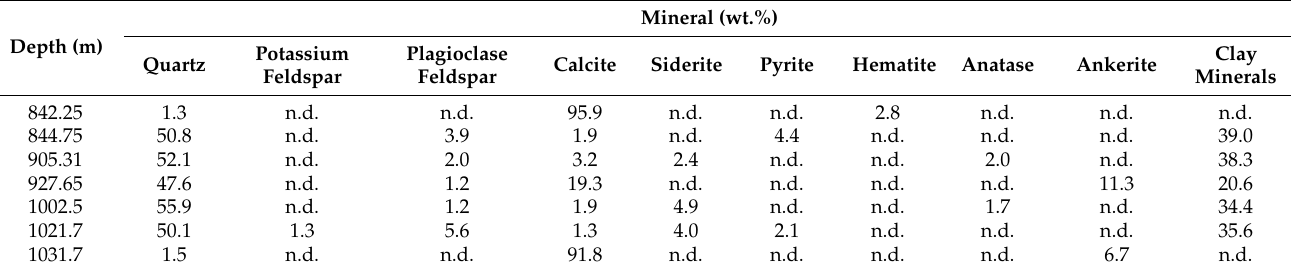
Table 5. Quantitative X-ray diffraction analysis of sedimentary rocks from well Chaiye 2.